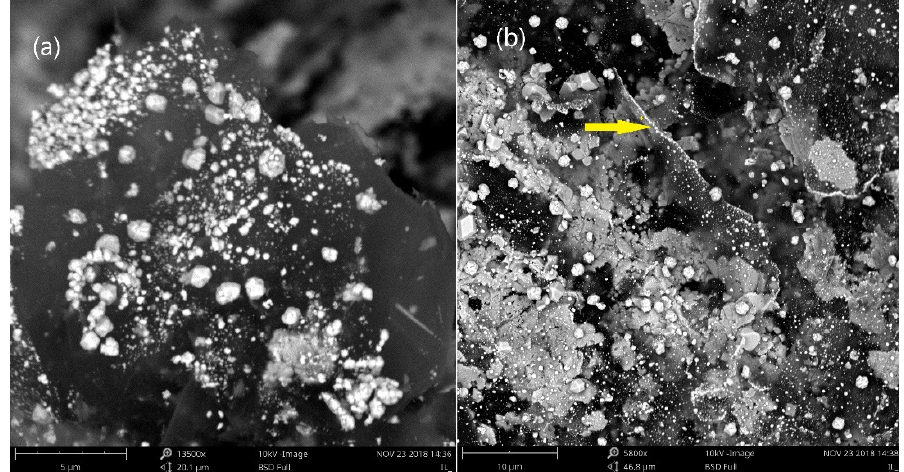
Figure 2. Copper (white structures in pictures) grown on rGSS deposited on carbon paper. SEM images of ( a ) distinct rGSS particle with copper on it and ( b ) small coper crystals attached to the edges (yellow arrow) of rGSS flakes.